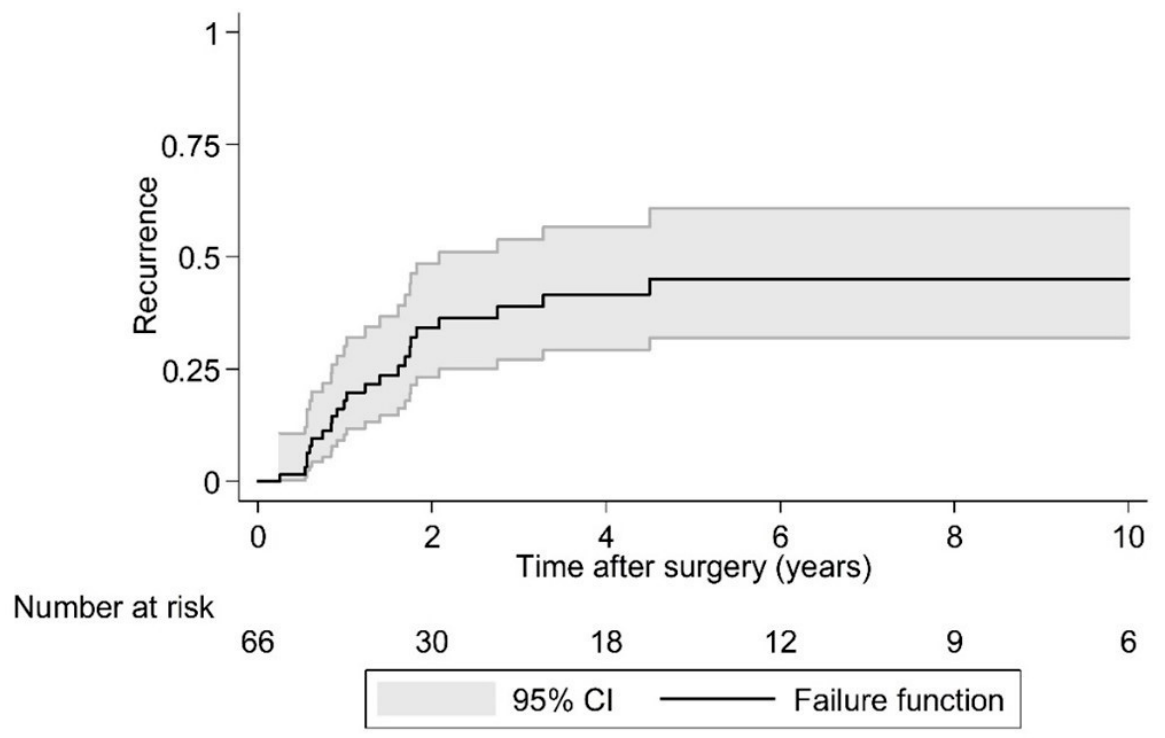
Figure 2. Kaplan-Meier analysis of time to first local recurrence following surgery. Note: There are 66 cases in this analysis because in two cases the timing of local recurrence was unknown.